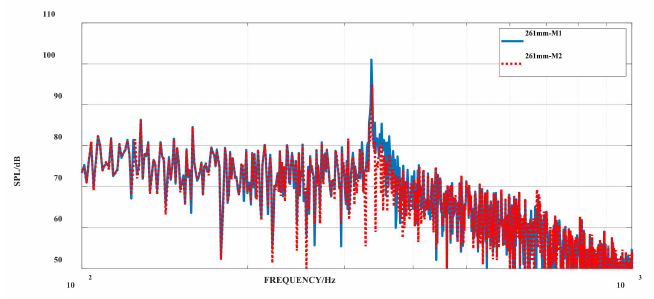
Figure 7. Calculation results of the noise power